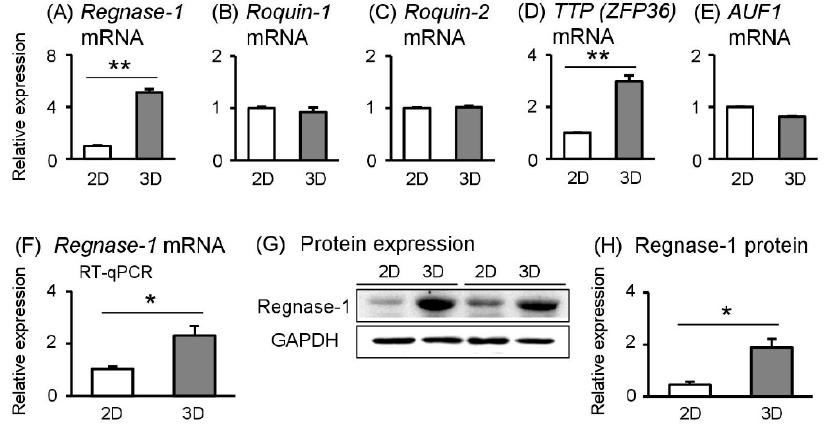
Figure 3. Effects of 3D culture conditions on RNase of inflammatory cytokine in Sw.71 cells. Sw.71 trophoblast cells were incubated for 24 h in 2D or 3D culture plates. ( A – E ) After 24 h incubation, regnase-1 , roquin-1 , roquin-2 , TTP , and AUR1 mRNA levels were measured using next-generation sequencing ( n = 3). ( F ) Regnase-1 mRNA levels were measured using RT-qPCR ( n = 4). ( G , H ) Regnase-1 and GAPDH protein levels in the cell lysates were detected using Western blot. Representative data are shown. Data are expressed as mean ± SEM ( n = 4 in each experiment). Significant differences were detected using a t -test; p < 0.05 (*) p < 0.01 (**).